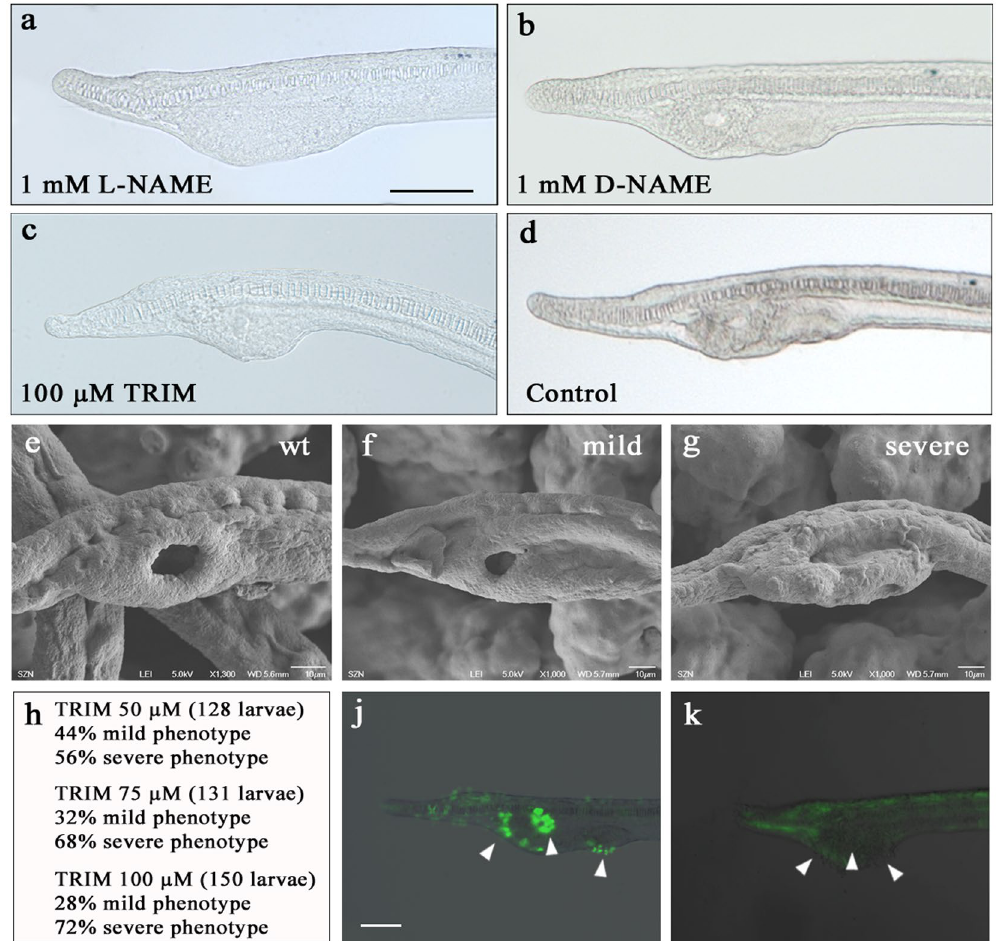
Figure 4. Drug treatments of amphioxus embryos. Amphioxus embryos were treated with L-NAME, D-NAME and TRIM, then the phenotype of 72 hpf larvae was observed. 1 mM L-NAME induces malformations in the mouth and gill slits area ( a ), not observed in the case of 1 mM of the D- enantiomer (D-NAME) ( b ). 100 µ M TRIM-treated larvae show a phenotype similar to that observed with L-NAME ( c ). Control untreated larva kept in FSW ( d ). Next, 100 µ M TRIM-treated larvae were observed by SEM. Control larvae in DMSO/FSW ( e ). TRIM-treated larvae with mild and severe phenotype ( f–g ). Percentages of larvae with mild and severe phenotypes at increasing drug concentrations, and the respective number of larvae observed ( h ). NO detection by DAF-FM-DA in untreated larvae mouth and gill slits are shown by arrowheads in ( j ). The absence of NO in mouth and gill slits of TRIM-treated larvae is indicated by arrowheads ( k ). Scale bars: 50 μ m in ( a – d ) and ( k – j